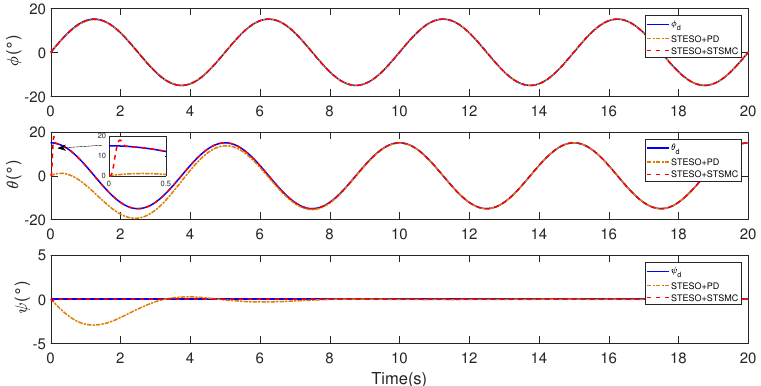
Figure 7. Simulation curves of attitude angle: STSMC vs. nonlinear